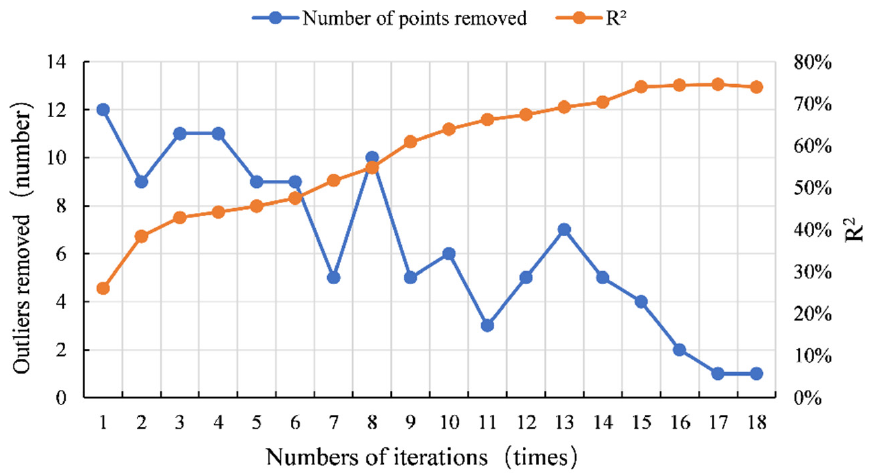
Figure 8. Relation between iteration times and number of outliers removed.